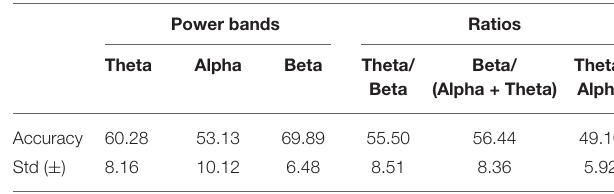
TABLE 3 | Reference values for classification accuracy and standard deviation (std) using